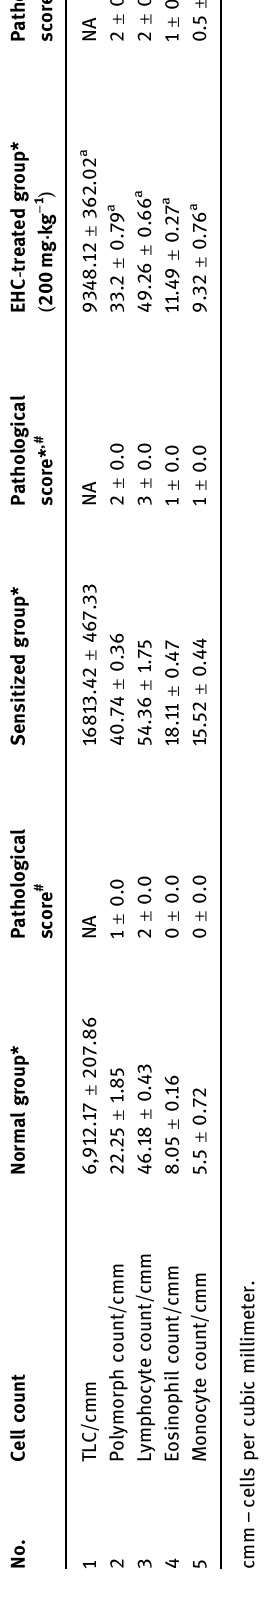
Table 8: Serum bicarbonate level and protein levels No. Treatment